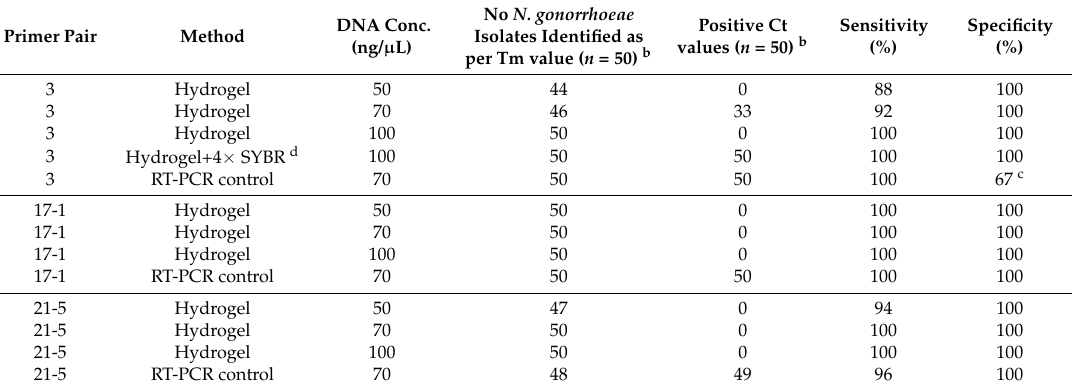
Table 5. Evaluation of hydrogel and RT-PCR methods using varying concentrations of N. gonorrhoeae DNA ( n = 50) a and diagnostic primer pairs 3, 17-1, and 21-5.